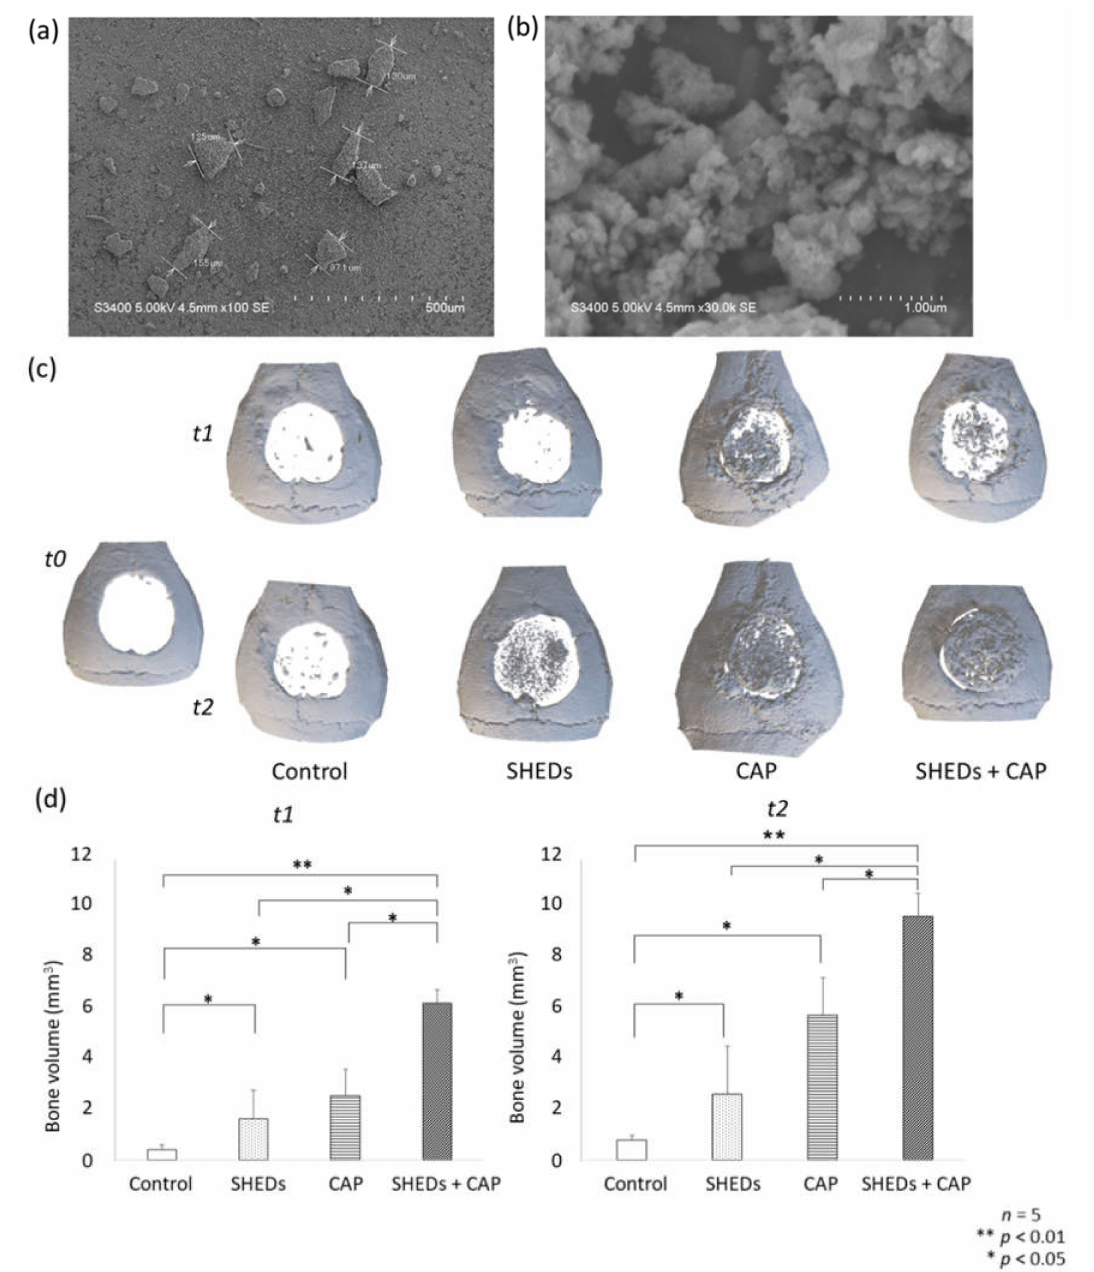
Figure 1. SEM analysis of nanostructured CAP granules showing the mean size of CAP particles. analysis from 3D images of regenerated bone. No newly formed bone was observed at t0 in any group ( c ). At t1 (4 weeks), a small amount of newly formed bone was detected in the control and SHEDs groups, and newly formed bone was more prominent in the CAP and SHEDs + CAP groups than in the control group. Newly formed bone volume was significantly higher in the SHEDs, CAP, and SHEDs + CAP groups at t1 and t0 ( d